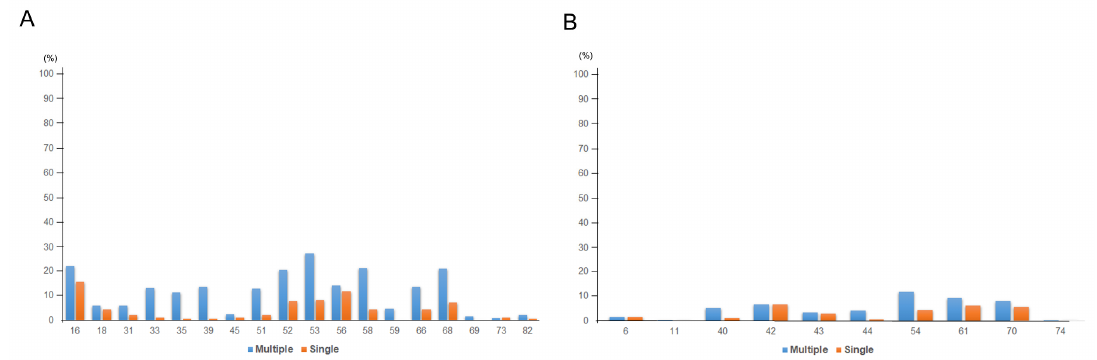
Figure 2. HPV genotype prevalence in single and multiple HPV infection ( A ) among HR-HPV and ( B ) LR-HPV.